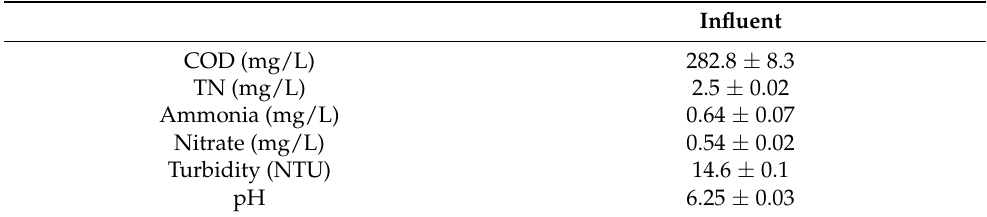
Table 1. Influent characteristics for the RBC-ME bioreactor employing a polysulfone membrane in the